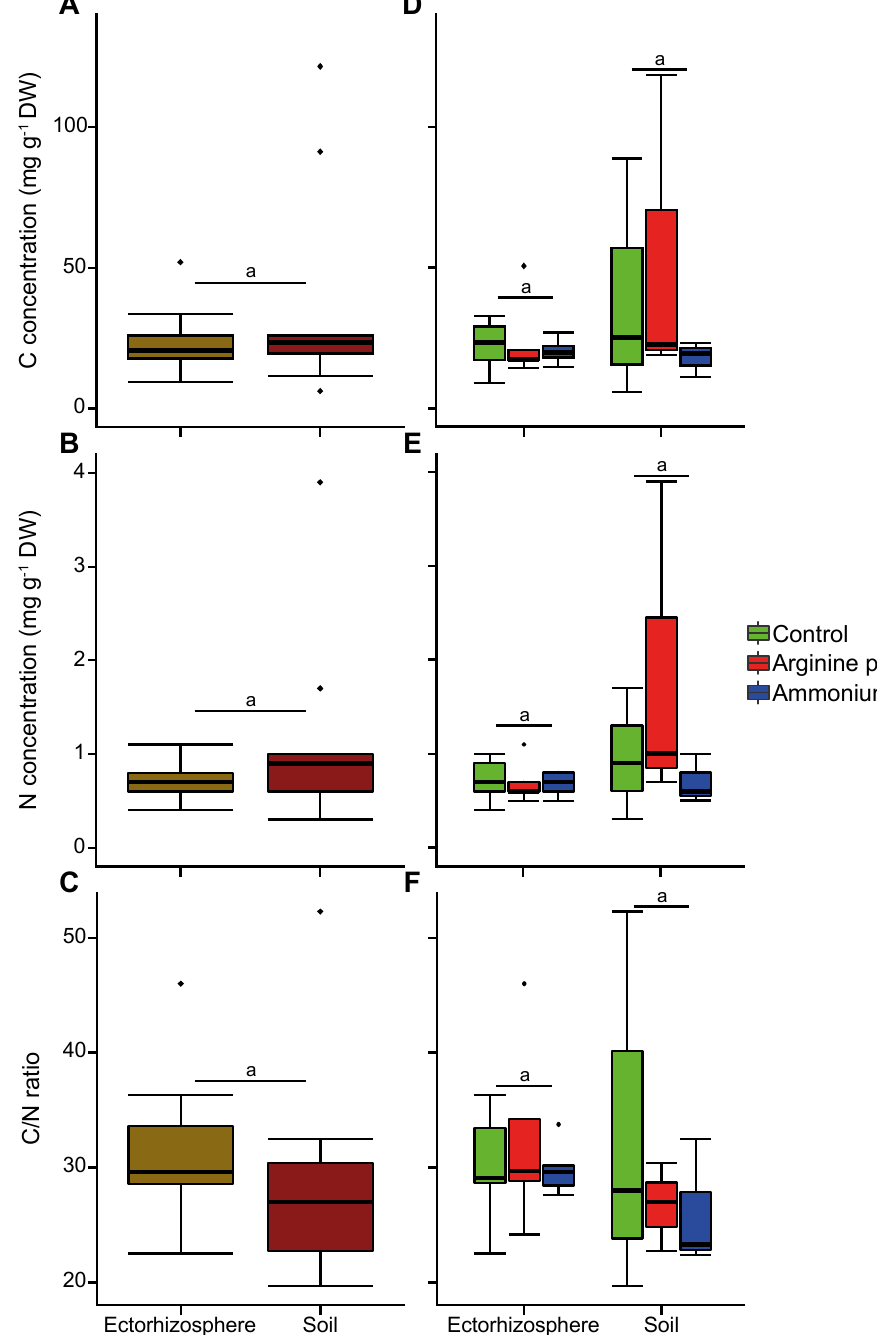
Figure 1. Boxplots of the mass fraction of carbon ( A , D ), nitrogen ( B , E ) and C to N ratio ( C , F ) in ectorhizosphere and scarified soil samples. Panels ( A – C ) depict the nutrient content per sample, and panels ( D – F ) depict the same data split by fertilization treatment. The lowercase letters in the upper part of the boxplots represent Fisher’s least significant difference (LSD) statistical grouping testing sample type effect. Whiskers represent 1.5 × inter-quartile range (IQR).